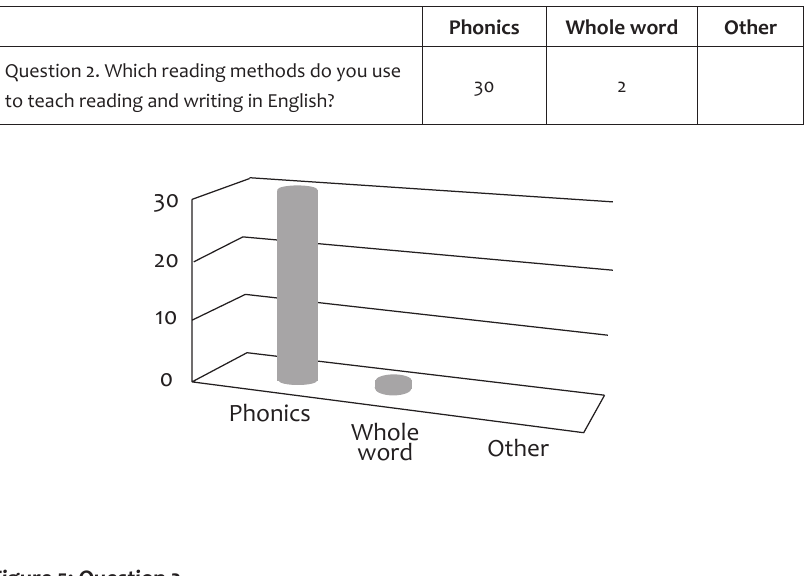
Figure 5: Question 2